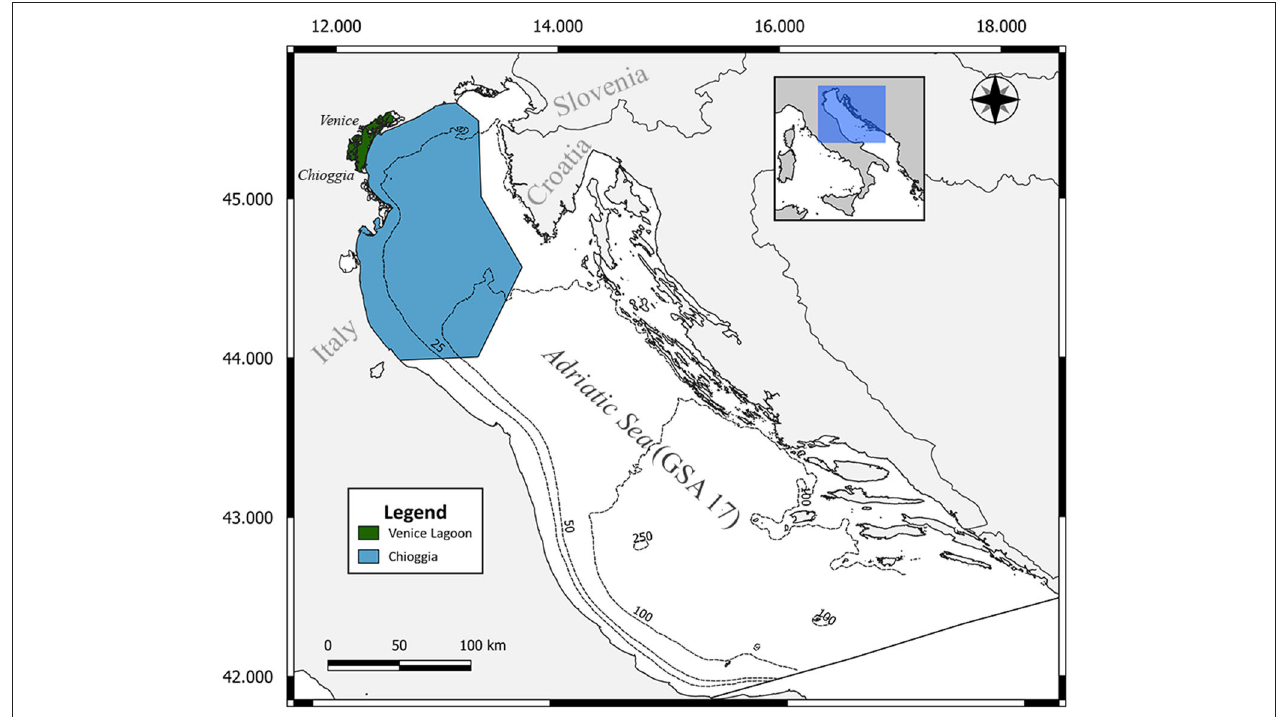
FIGURE 1 | Map of the investigated areas. The two-coloured polygons represent the fishing grounds of Chioggia (light blue) and Venice